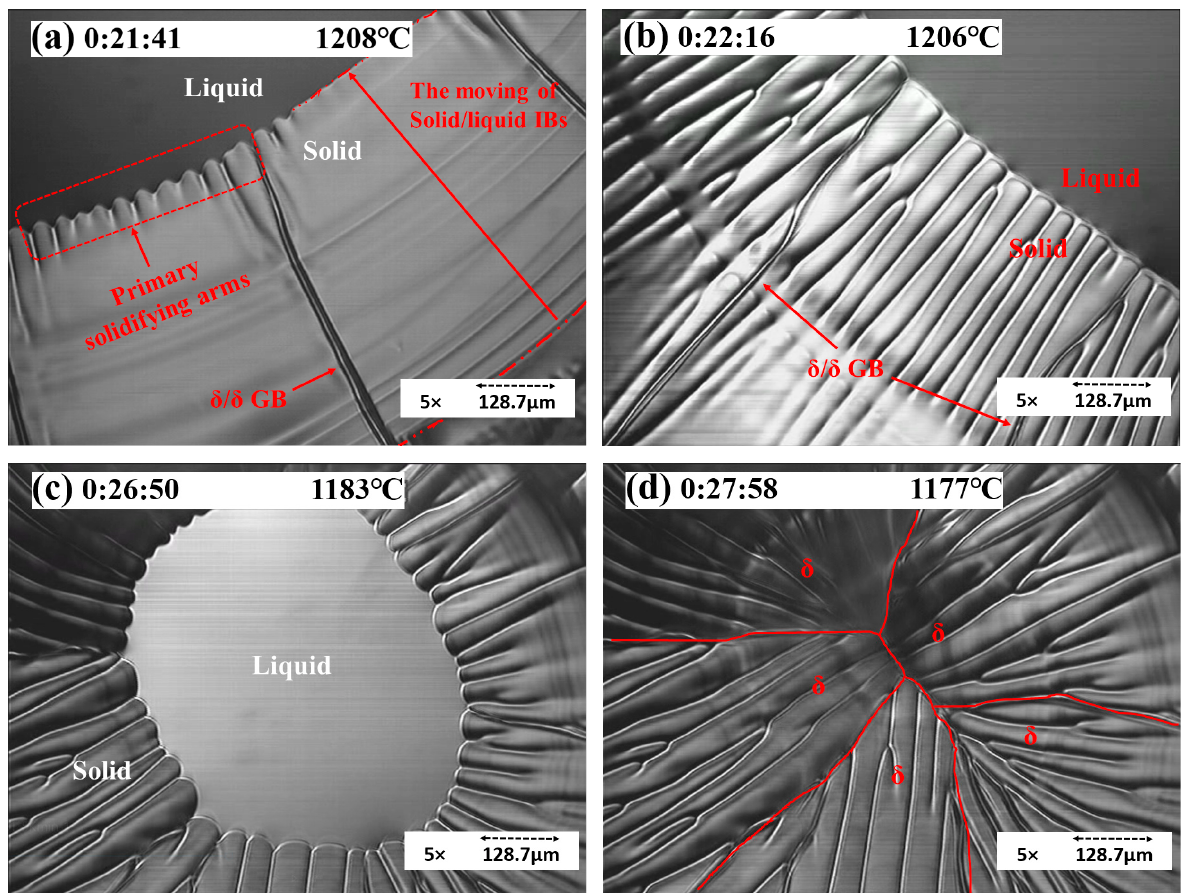
Figure 8. Concentric HTCM revealing the solidification process of S32101 under a 5 ◦ C/min cooling rate: ( a ) the movement of S/L IB, ( b ) the growth of solidifying arms, ( c ) the residual liquid pool, and ( d ) the morphology of δ solids (cellular